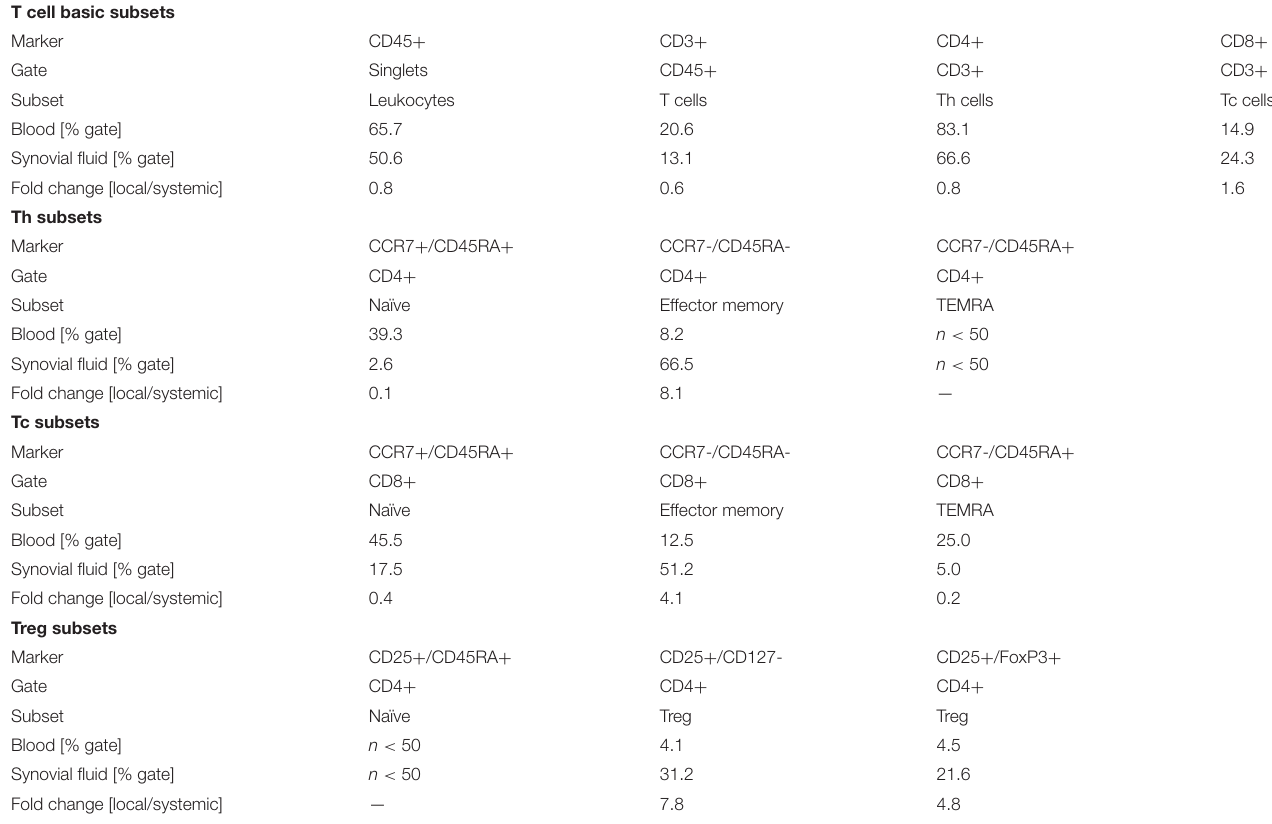
TABLE 2 | Systemic and local T cell subsets. T cell basic